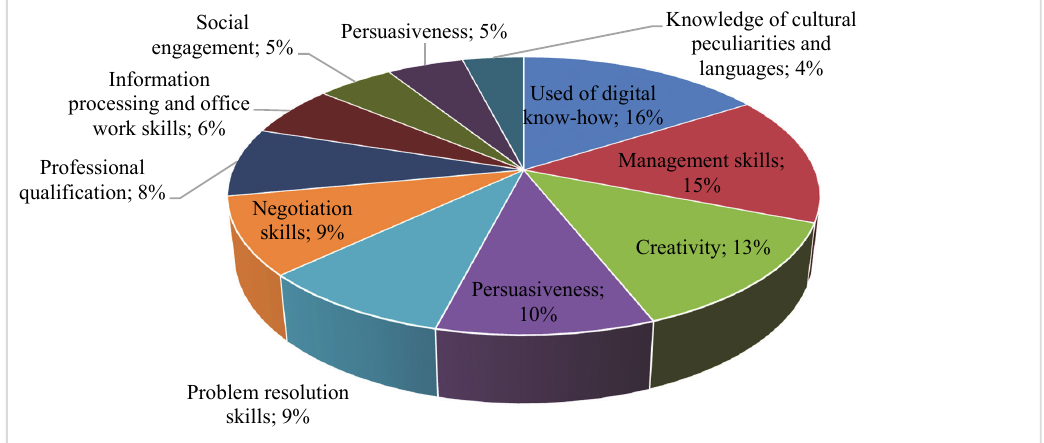
Fig. 1. Skills demanded by UK enterprises and public sector organizations. Source: based on